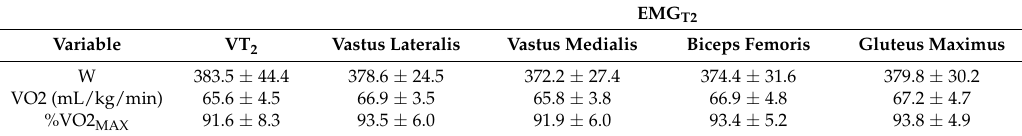
Table 3. Mean values of the power output (W), VO2, and %V obtained at the second electromyographic threshold (EMG T2 ) and at the second ventilatory threshold (VT 2 ). All values are expressed as mean ± SD. EMG T2 Variable